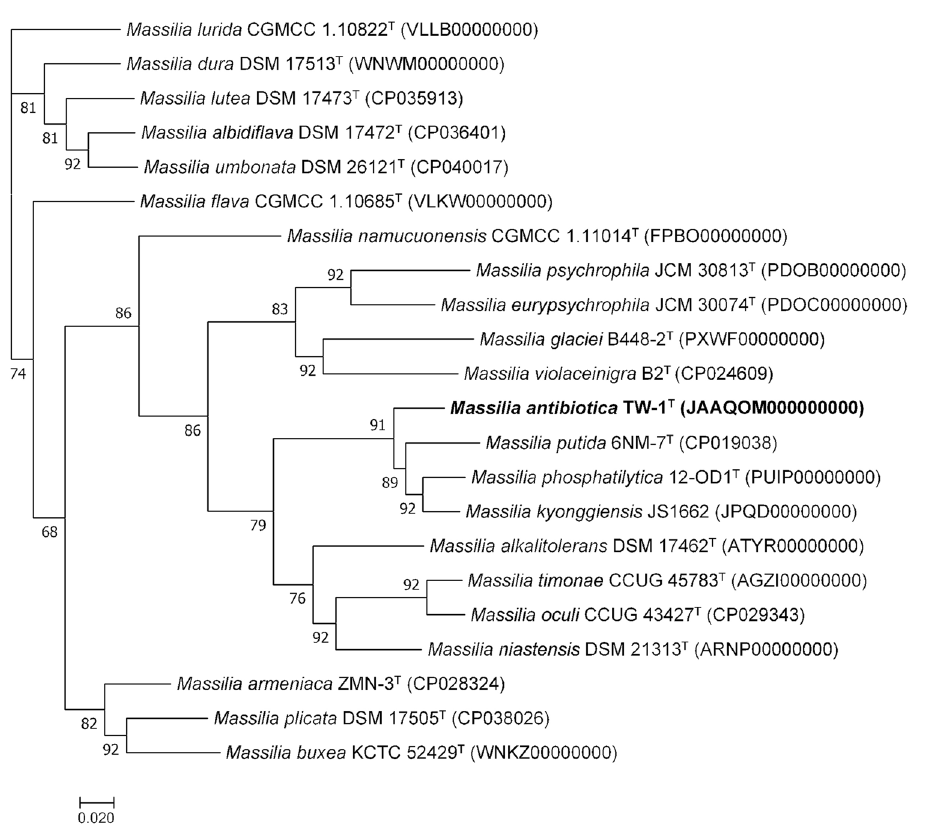
Figure 3. Phylogenomic tree constructed using UBCGs (concatenated alignment of 92 core genes). Bar, 0.020 substitution per nucleotide